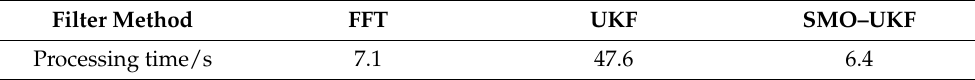
Table 4. Comparison of computing time of three filtering